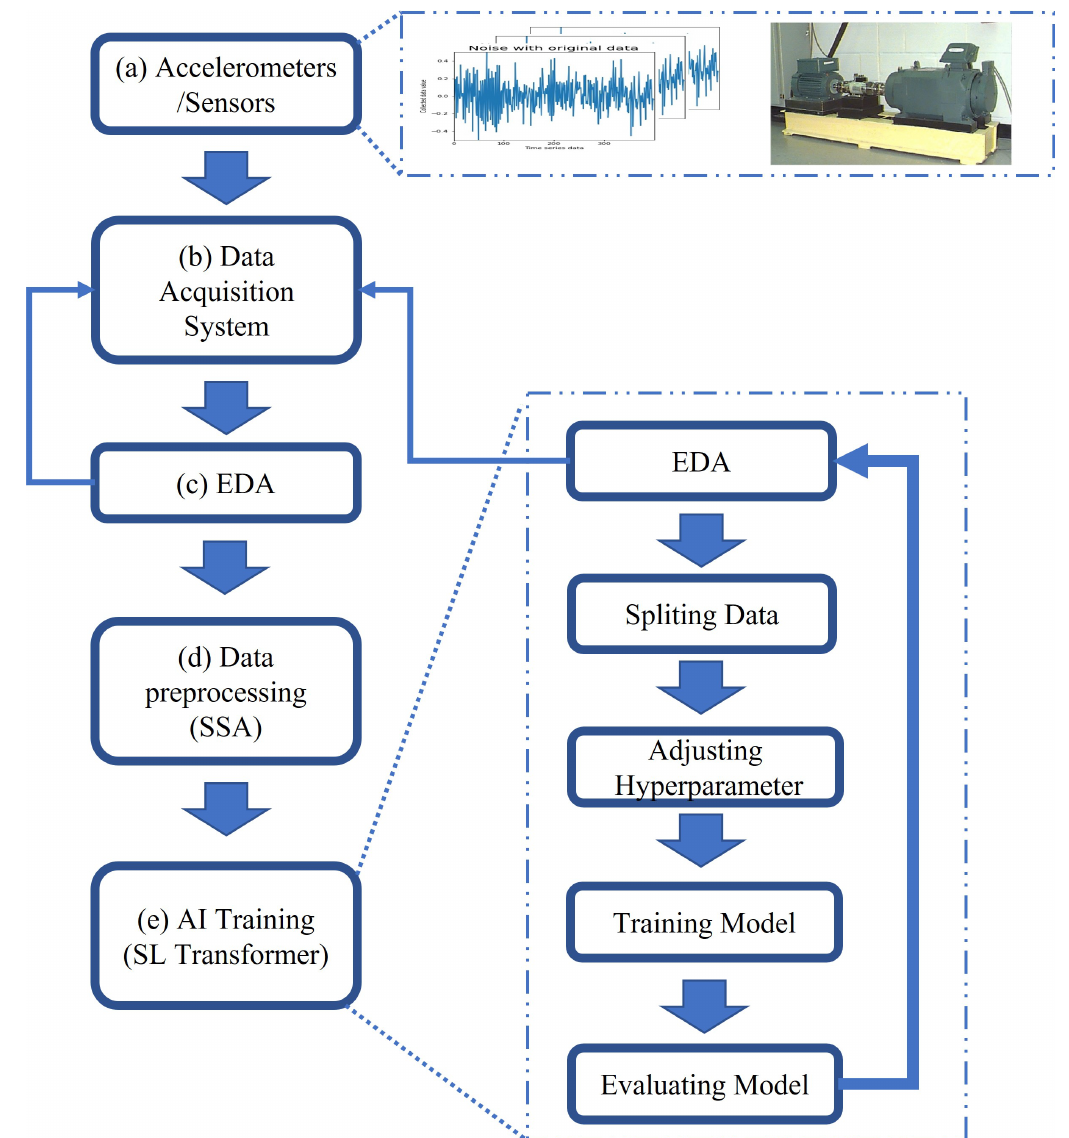
Figure 5. The block diagram of the proposed research